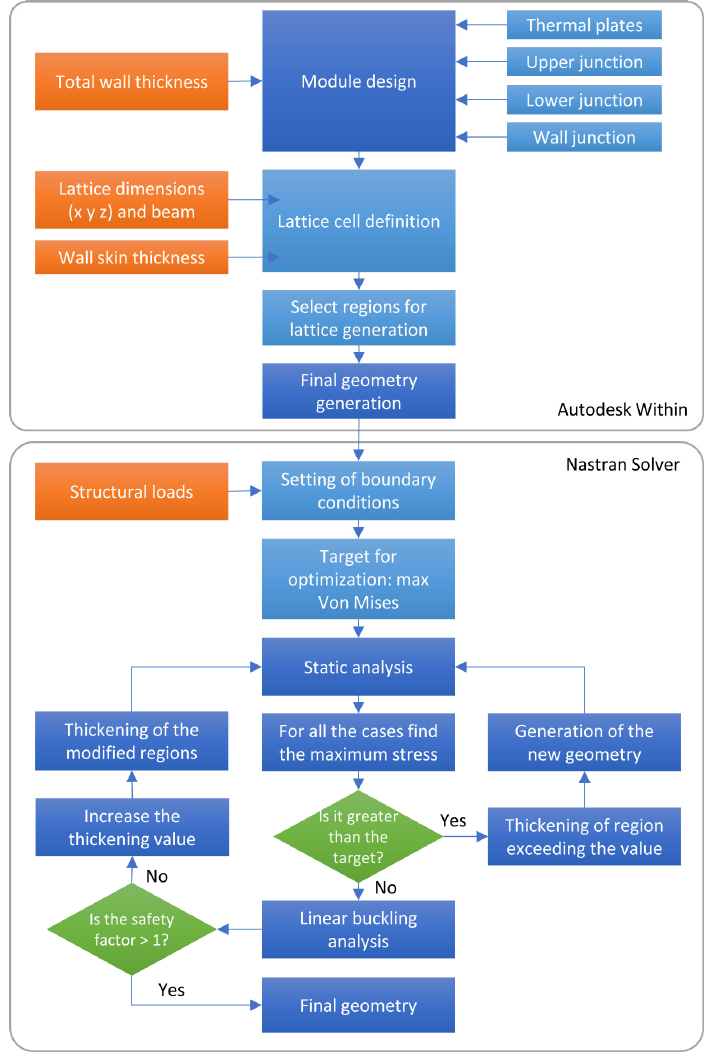
Figure 12. Lattice structures optimization design framework.